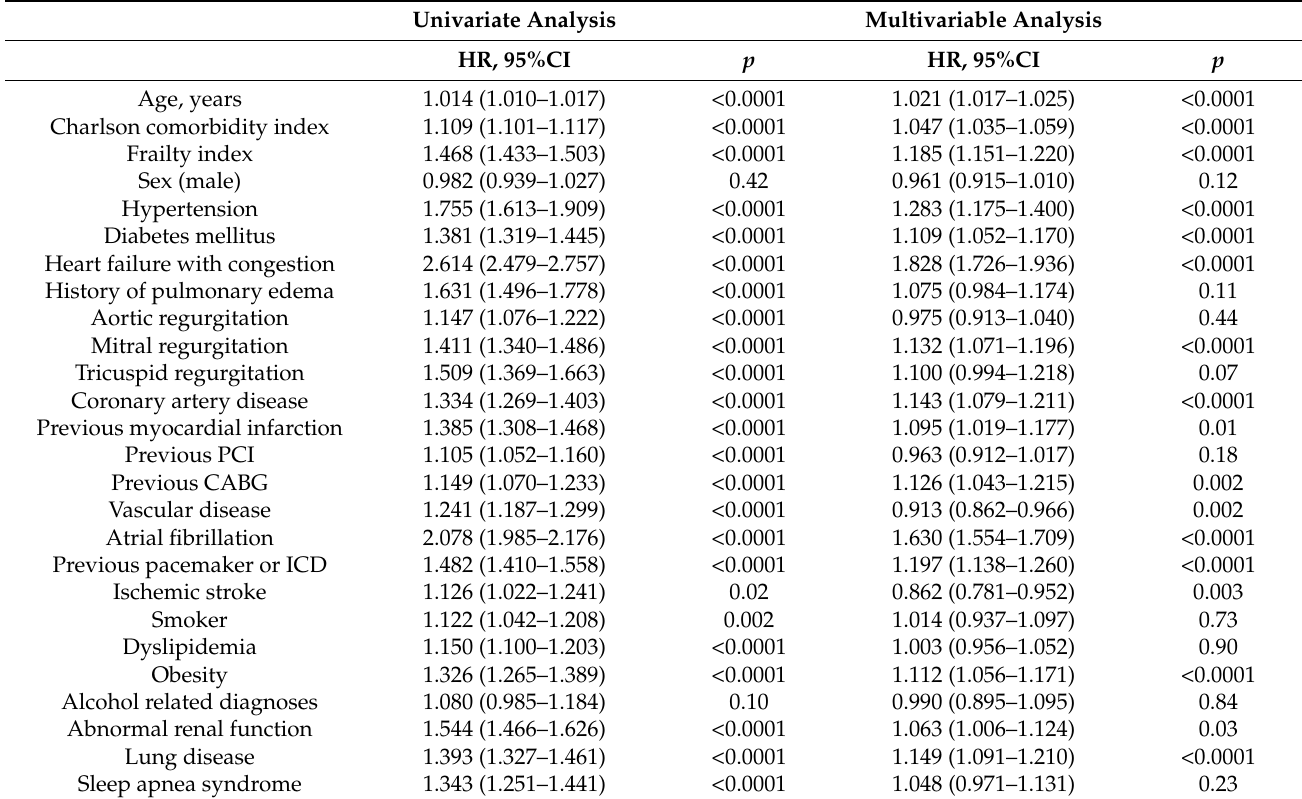
Table 4. Predictors of rehospitalization for HF in patients treated with